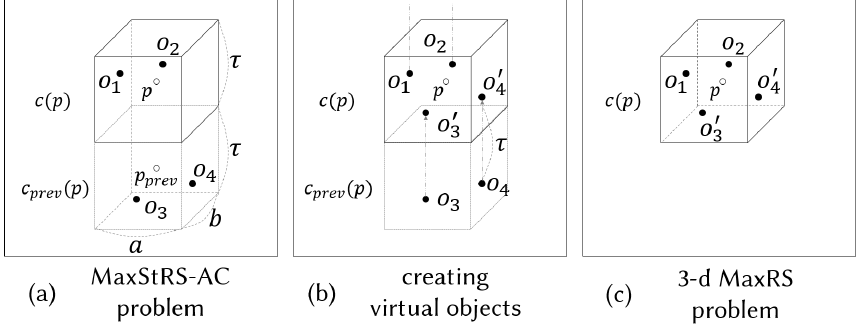
Figure 10. A motivating example of transforming the MaxStRS-AC problem to the 3D-MaxRS